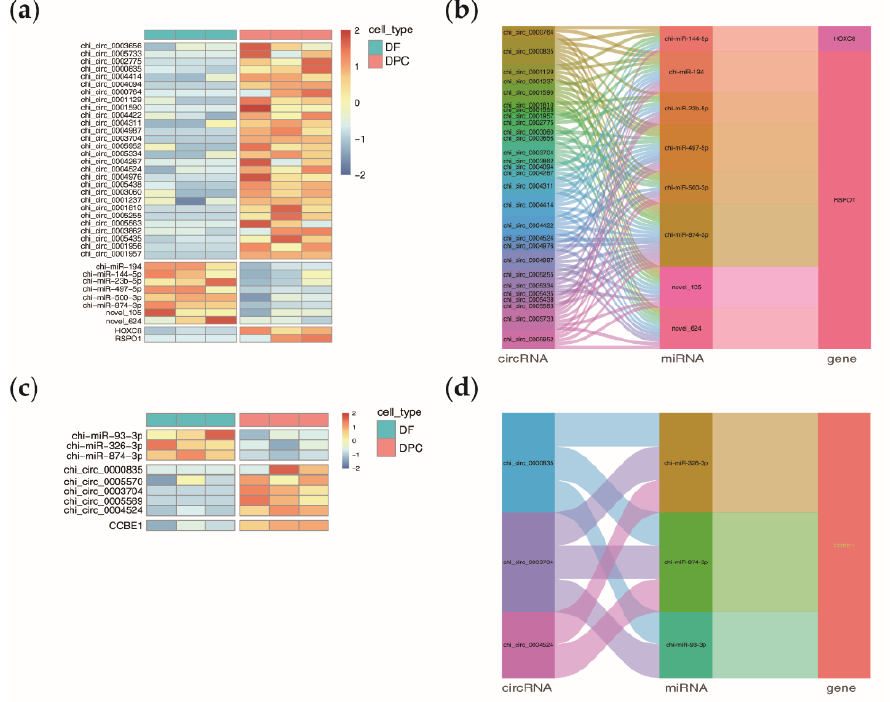
Figure 5. CircRNAs acting as ceRNAs in regulating the abundances of coding genes. ( a ) Heatmap showing the relative expression of transcripts between two cell samples; ( b ) Sankey graph showing the relationship between circRNAs, miRNAs, and coding genes ( HOXC8 and RSPO1 ); ( c ) Heatmap showing the relative levels of intronic circRNAs (i.e., chi_circ_0005569 and chi_circ_0005570) and other transcripts between goat DPCs and DFs; ( d ) Sankey graph showing the interactive lines of circRNAs, miRNAs, and CCBE1 .